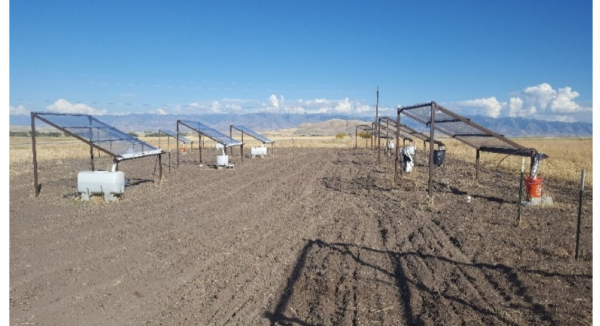
Figure 2. Shelters (2.1 × 2.5 m) were used to redistribute rain and snow as fewer, larger events at a dryland agriculture site, Utah, USA. Two of three rows of plots are visible in the